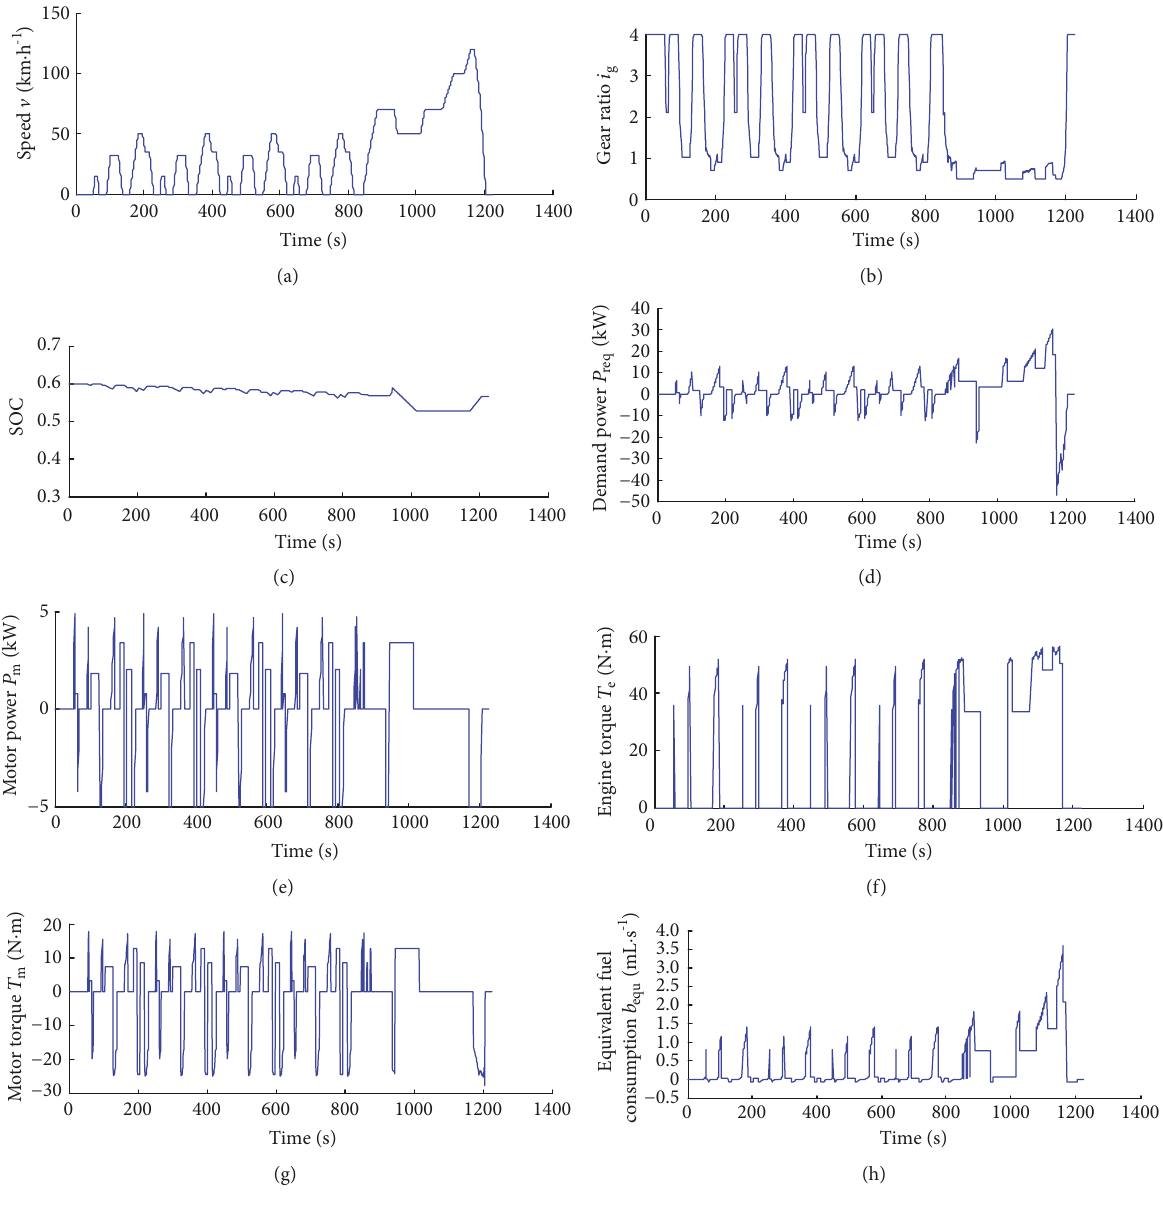
Figure 11: ECE EUDC simulation results based on